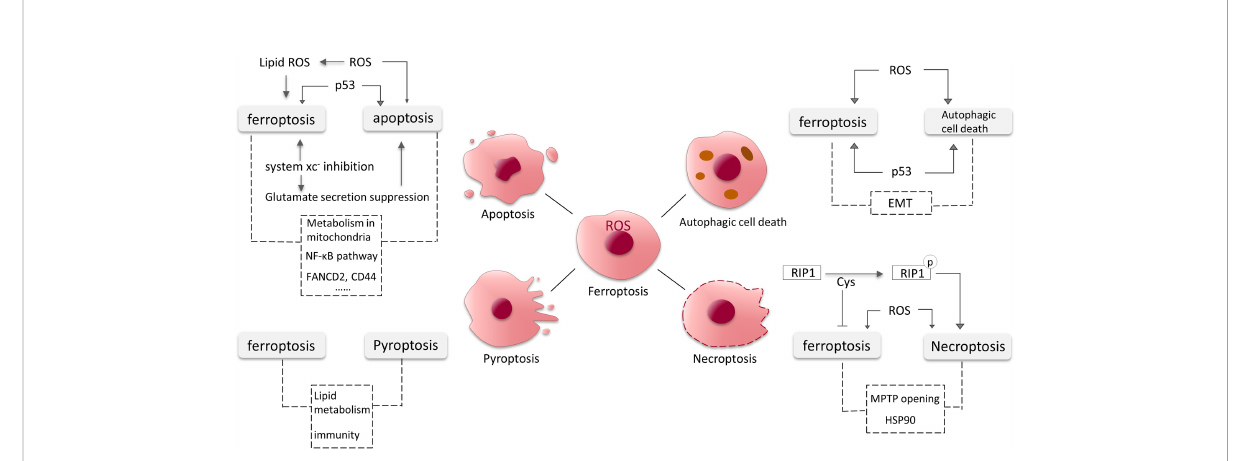
FIGURE 4 Crosstalk between ferroptosis, apoptosis, autophagic cell death, necroptosis and pyroptosis in glioma. The dotted lines represent possible intersections and require more research to